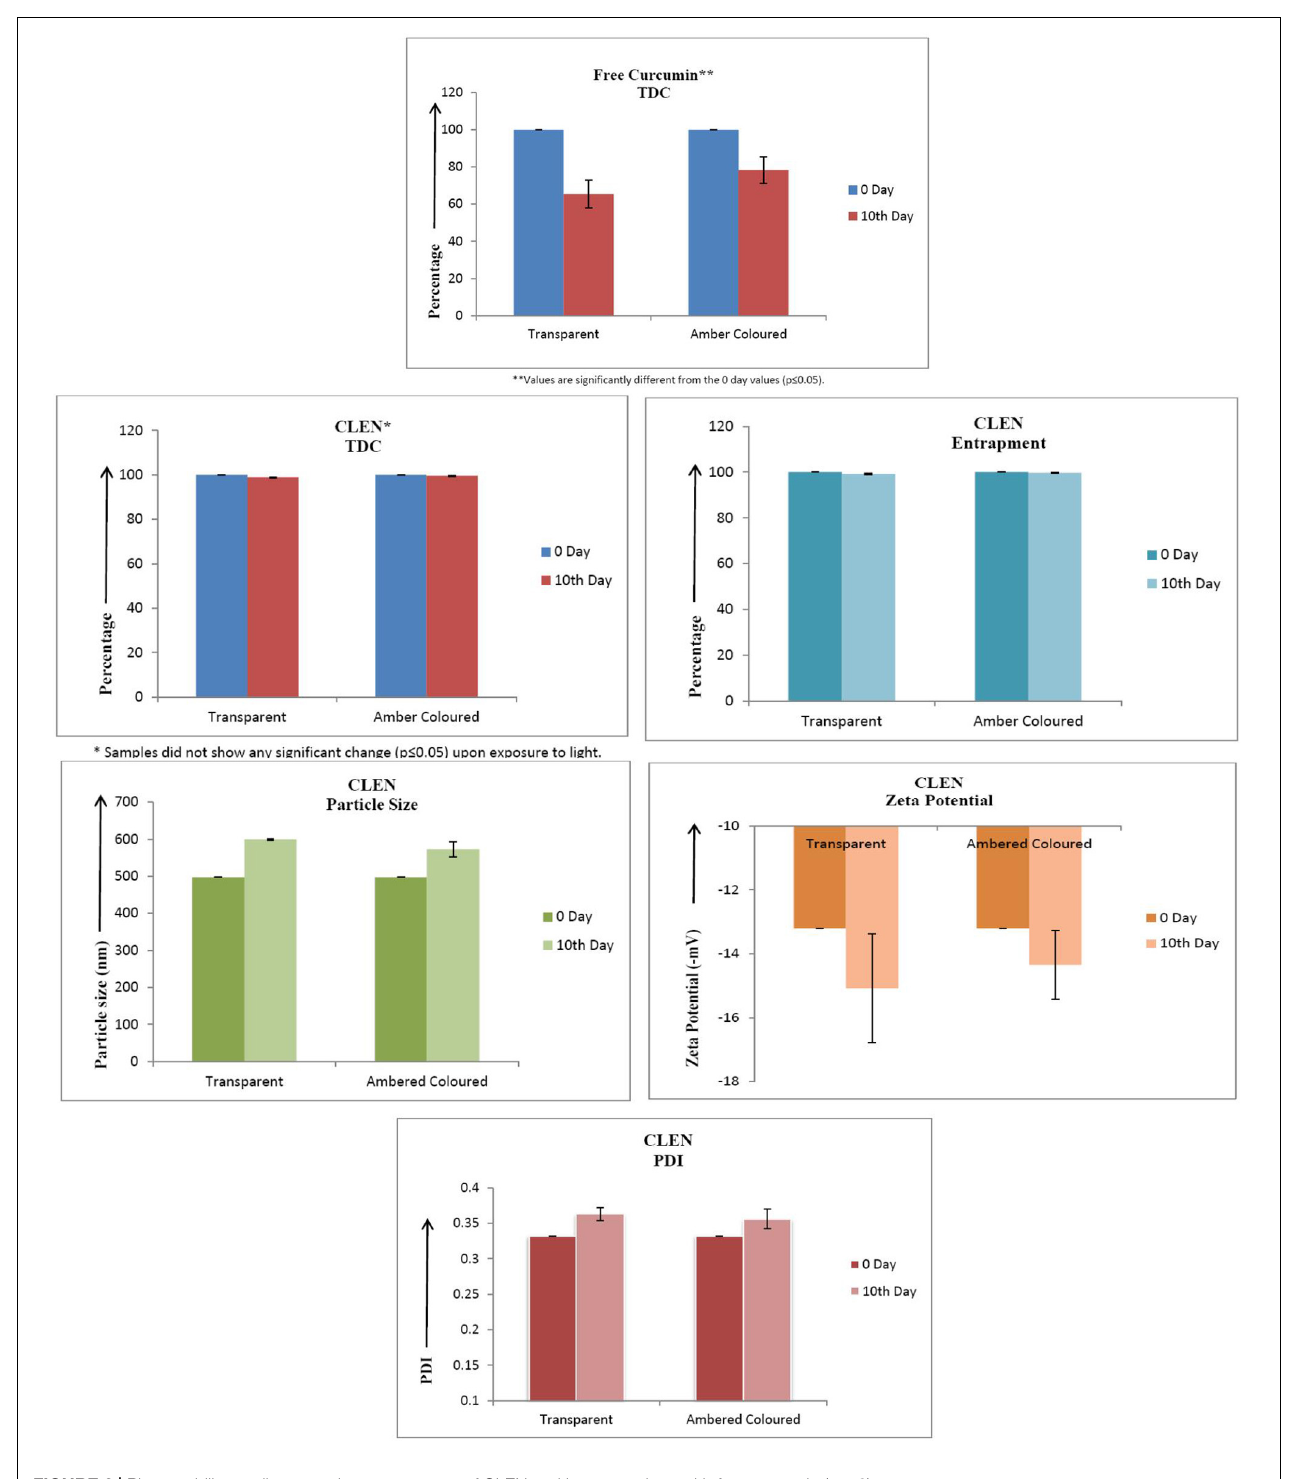
FIGURE 6 | Photostability studies on various parameters of CLEN and its comparison with free curcumin ( n = 3).